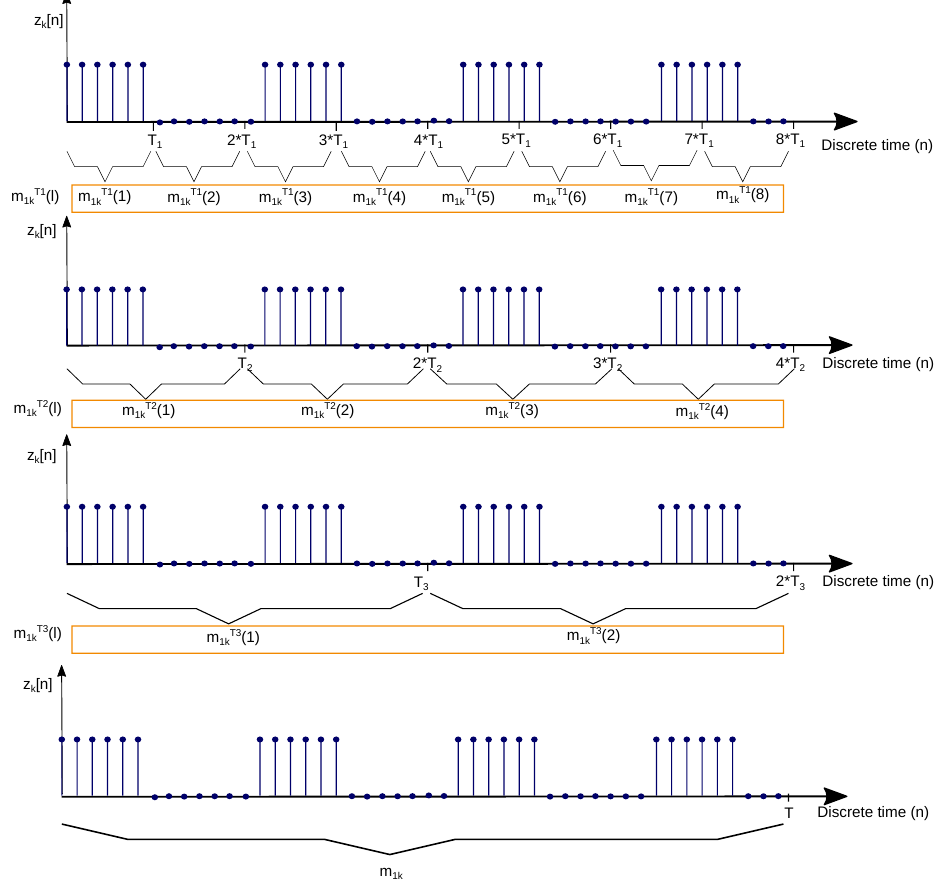
Figure 1. Calculation of the local means m T i